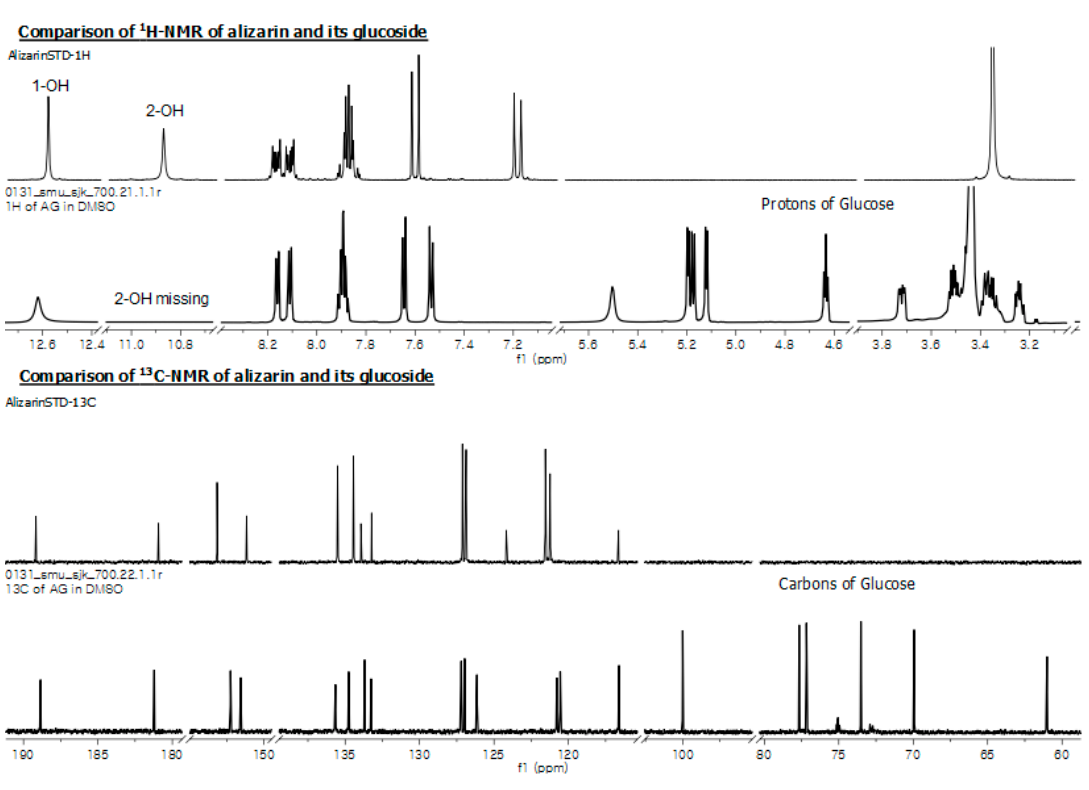
Figure 7. 1 H- and 13 C-NMR of alizarin and alizarin-2- O - β - D -glucoside. Table 1. Comparison of 1 H- and 13 C-NMR spectra of alizarin and alizarin 2- O -glucoside measured in DMSO- d 6 . Multiplicities are indicated by s (singlet), d (doublet), t (triplet), q (quartet), and m (multiplet), including coupling constant J .